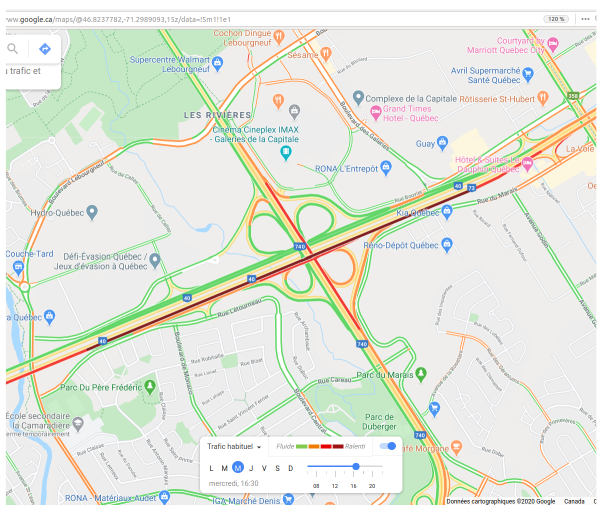
Figure 11. Traffic map with model Google Maps (GM) at 16:30 p.m. for 21 October 2020, over the junction of Aut. Félix-Leclerc and Aut. Robert-Bourassa, Quebec City.